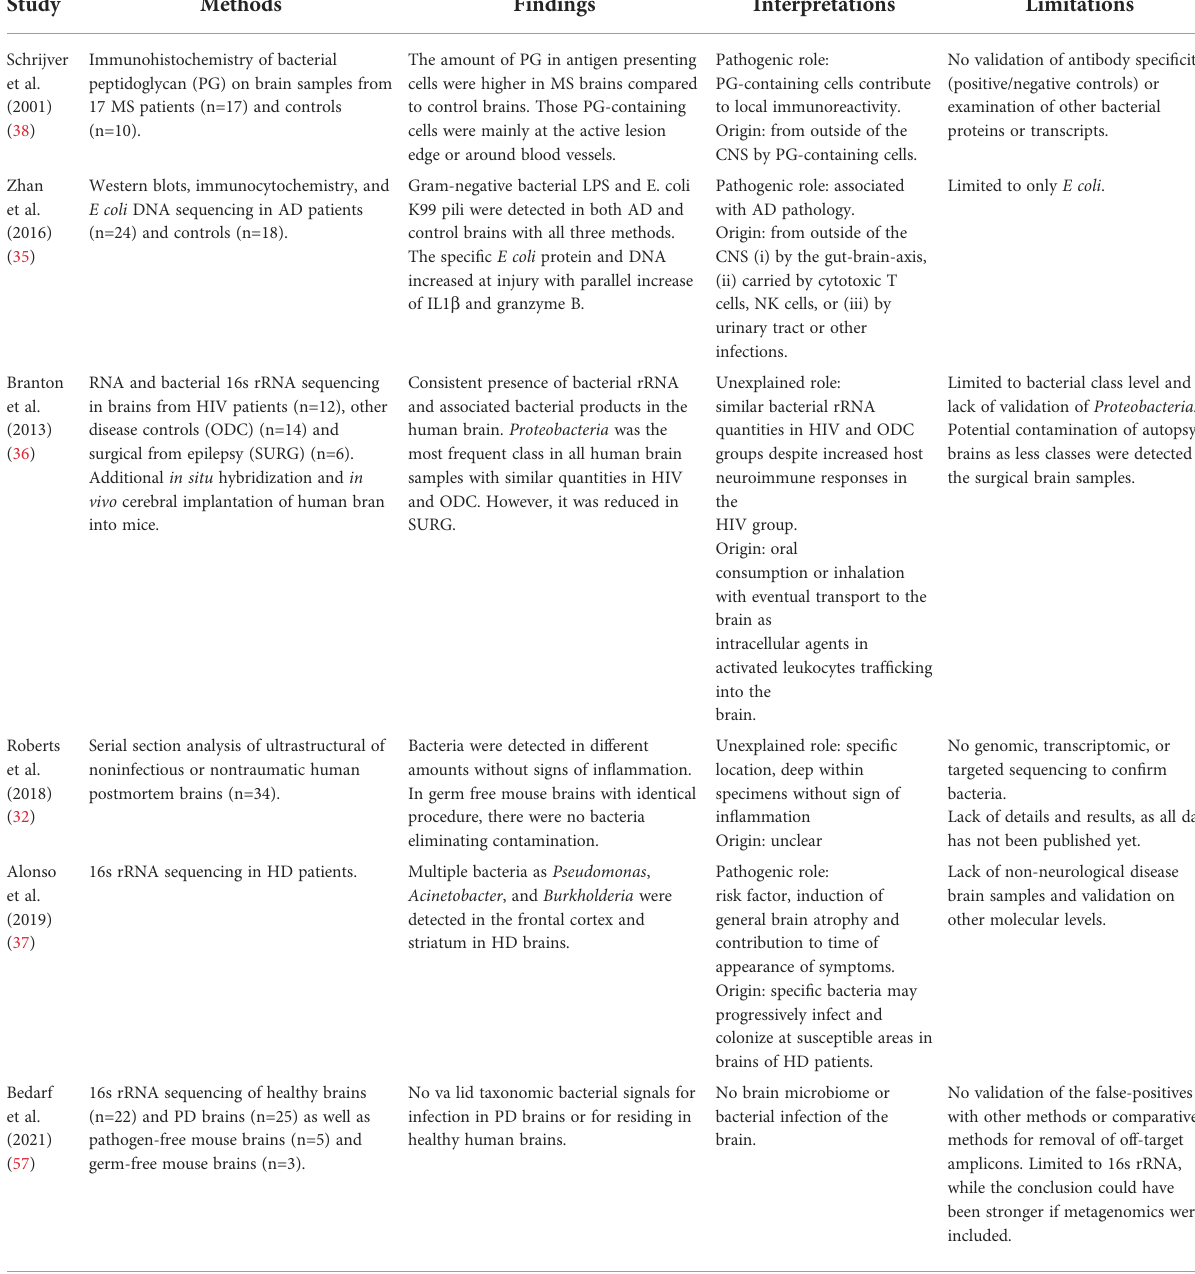
TABLE 1 Examination of bacteria in the human